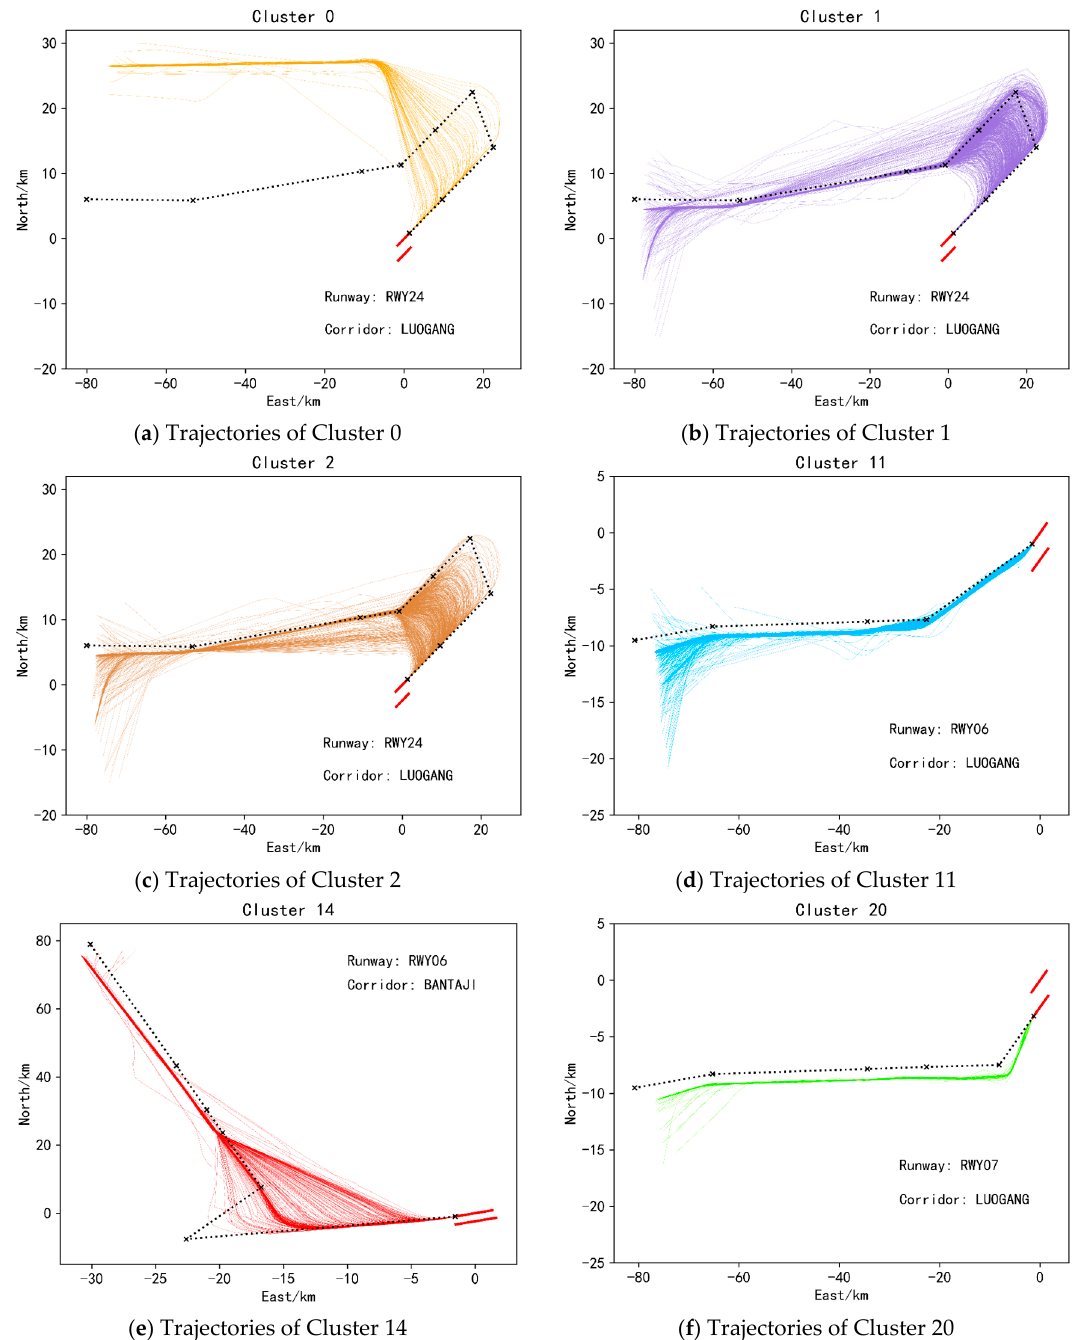
Figure 11. Two-dimensional plan view of some takeoff